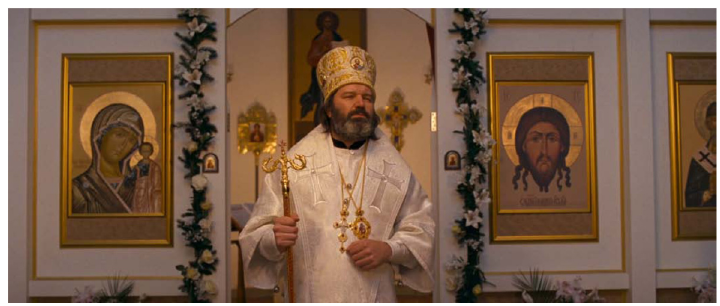
Figure 14. Leviathan (2014).